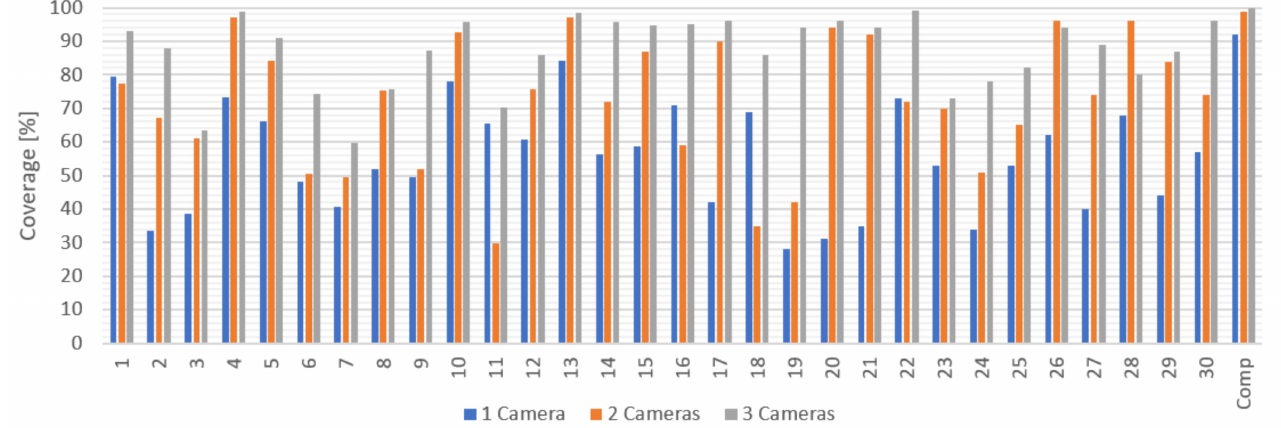
Figure 18. Relative camera coverage achieved by all individual human subjects (1 to 30) and the automated system